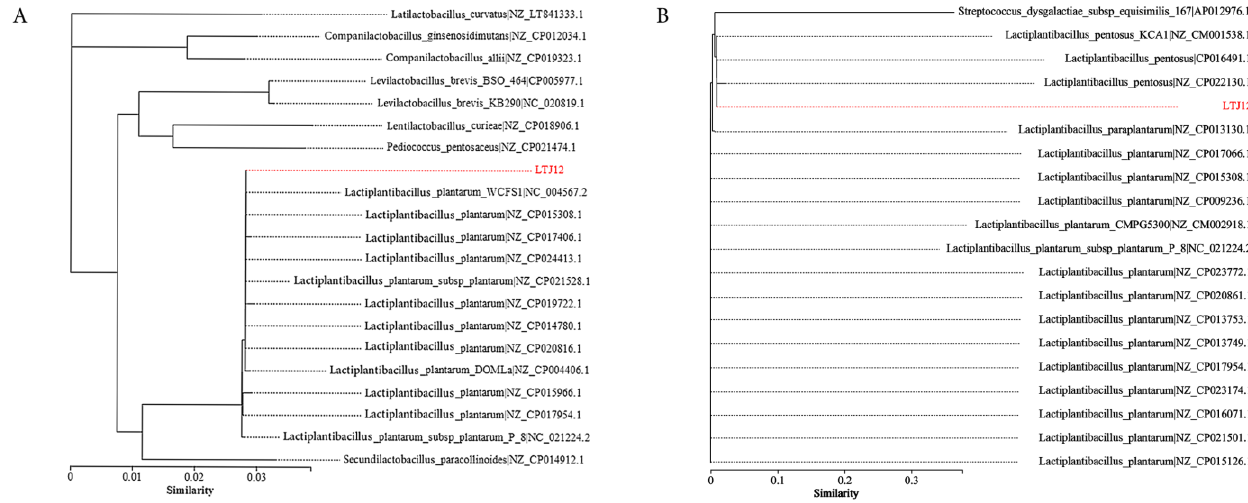
Figure 2. Phylogenetic tree of ( A ) 16S rRNA genes and ( B ) house-keeping genes. By comparing with the database, based on 16S rRNA sequence and housekeeping genes, 19 strains that were closest to LTJ12 at the species level were selected, and the NJ (Neighbor-Joining) method was selected using MEGA 6.0 software to construct the phylogenetic tree.